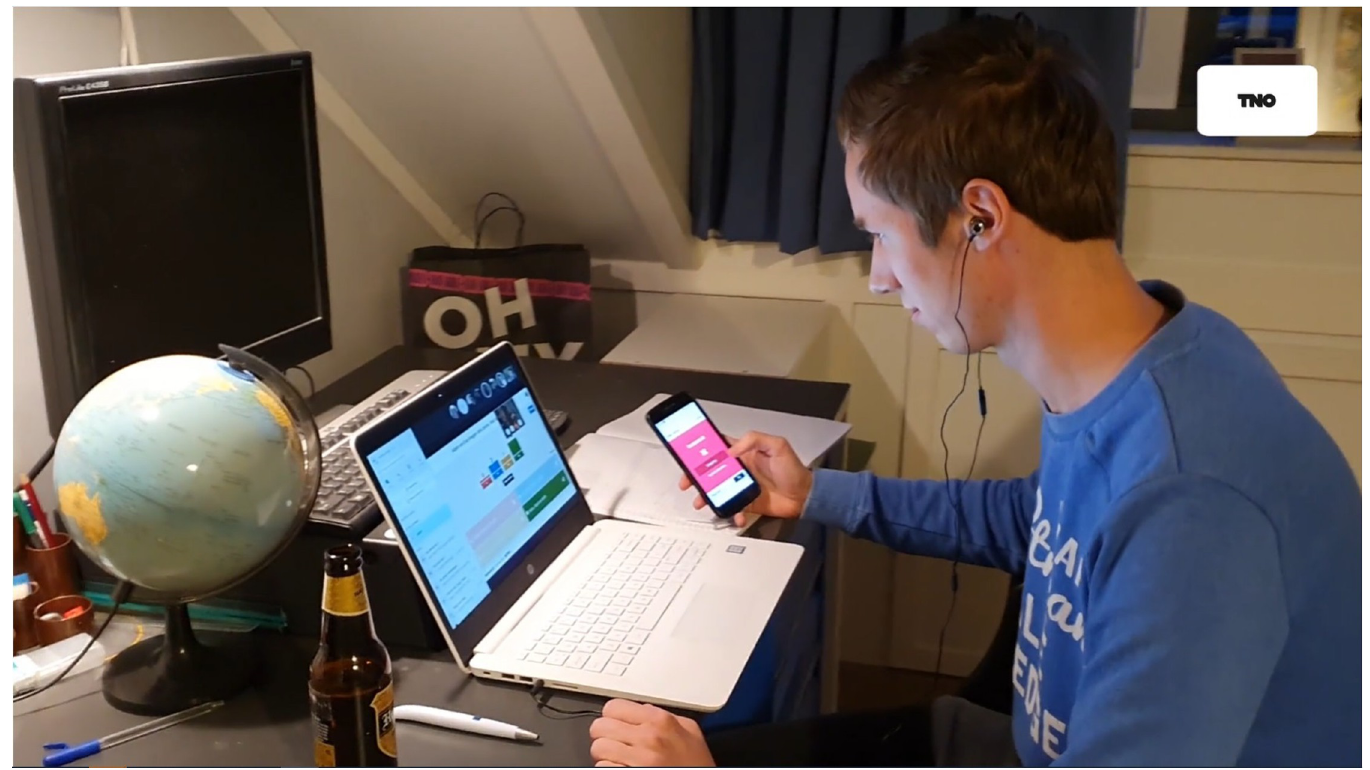
Fig 1. Screenshot scenario 1. Depicting student Maarten, 21 years, “meeting his friends online”.